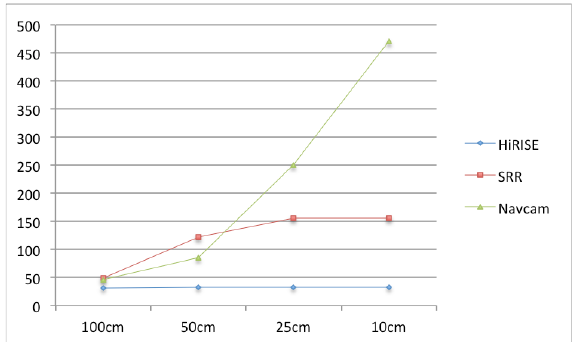
Figure 15 Rock frequency-size distribution for HiRISE, SRR and Navcam at MSL Sol 347.